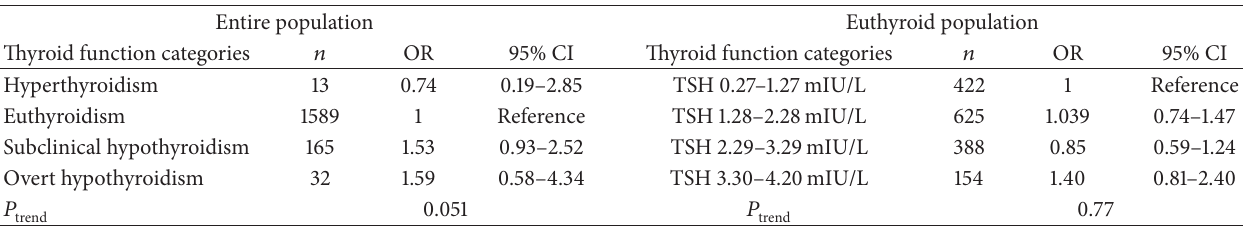
Table 4: Odds ratio of prevalent coronary heart disease by thyroid function categories.